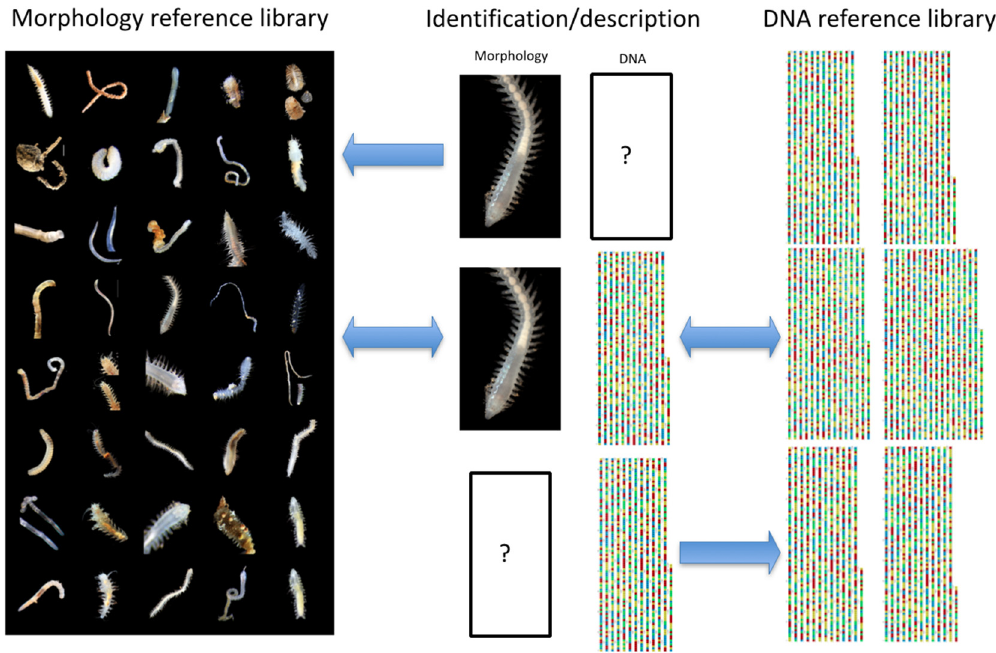
Figure 2. There are essentially two reference libraries of biodiversity information with regard our planet: one based on over 250 years of Linnean morphological taxonomy (left) and one based on approximately 25 years of DNA and protein sequencing (right). The central panel indicates the problem if only morphology or only DNA is obtained from an unknown organism—the data can only be compared with one library. In order to link both libraries, both kinds of data must be obtained from new species: DNA taxonomy.